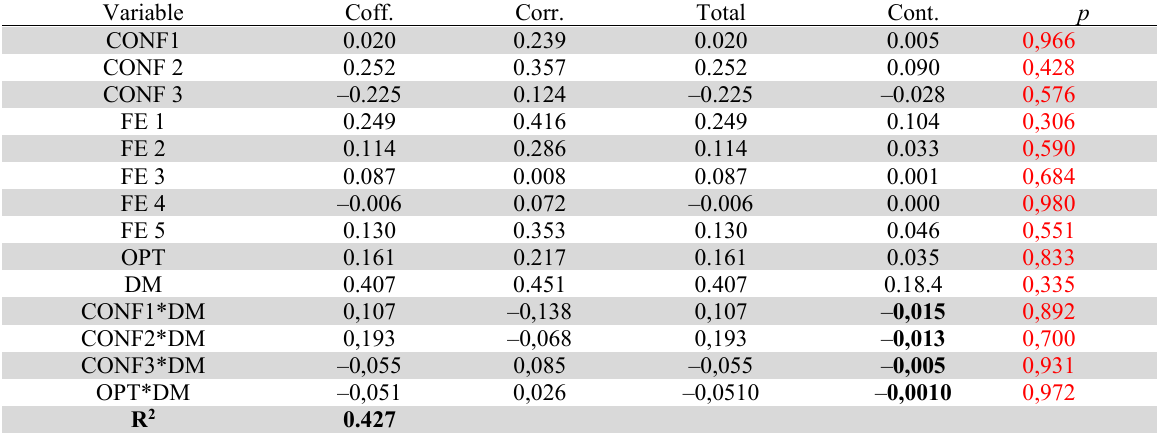
Influence and Contribution of CONF, OPT, FE, DM, DM*CONF and DM*OPT Towards D (Leverage Ratio) (Model II) Variable Coff. Corr. Total